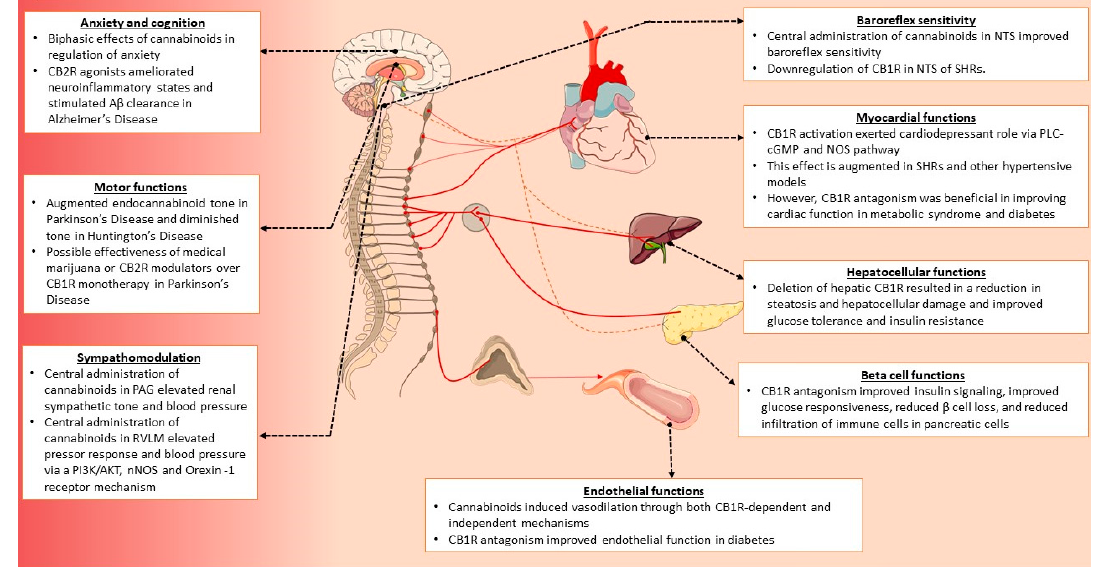
Figure 5. Functional overview of cannabinoid receptors in the CNS and peripheral tissues. CB1R is densely expressed in regions of the brain involved in the regulation of anxiety and cognition such as prefrontal cortex, amygdala, and hippocampus. Activation of the CB1R has been shown to have both anxiogenic and anxiolytic effects. Endocannabinoid tone is also altered in basal ganglia disorders such as Parkinson’s and Huntington’s Diseases. In neurological disorders characterized by case of cardiac and metabolic diseases, both central and peripheral CB1Rs are known to play a key role in their etiology. Central administration of cannabinoids into the PAG and RVLM triggers a sympathoexcitatory response, while administration in the NTS is known to improve baroreflex sensitivity and facilitates inhibition of pressor responses. Interestingly, CB1Rs were downregulated in the NTS of SHRs. However, myocardial CB1R was augmented in SHRs, and is implicated in